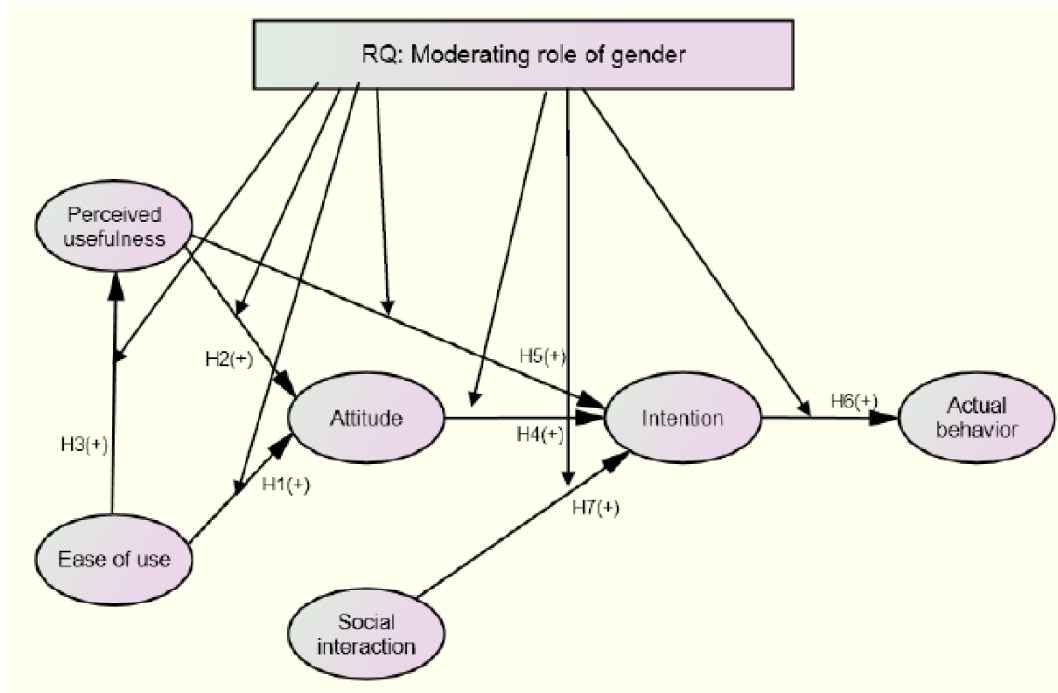
Figure 2. Proposed